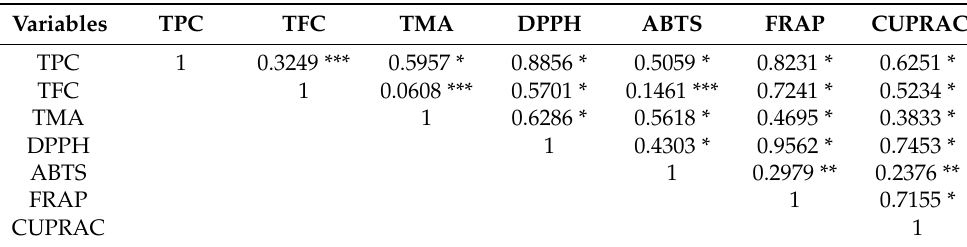
Table 4. Pearson correlation matrix of phenolic compounds and antioxidant activity of free and bound phenolics of eight peach varieties’ peel extracts.